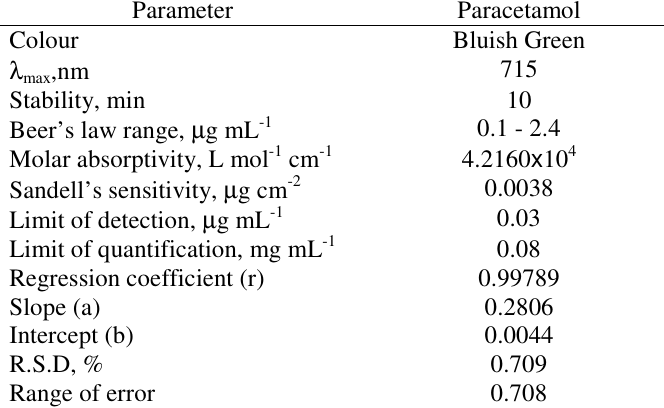
Table 1. Parameters for the spectrophotometric determination of